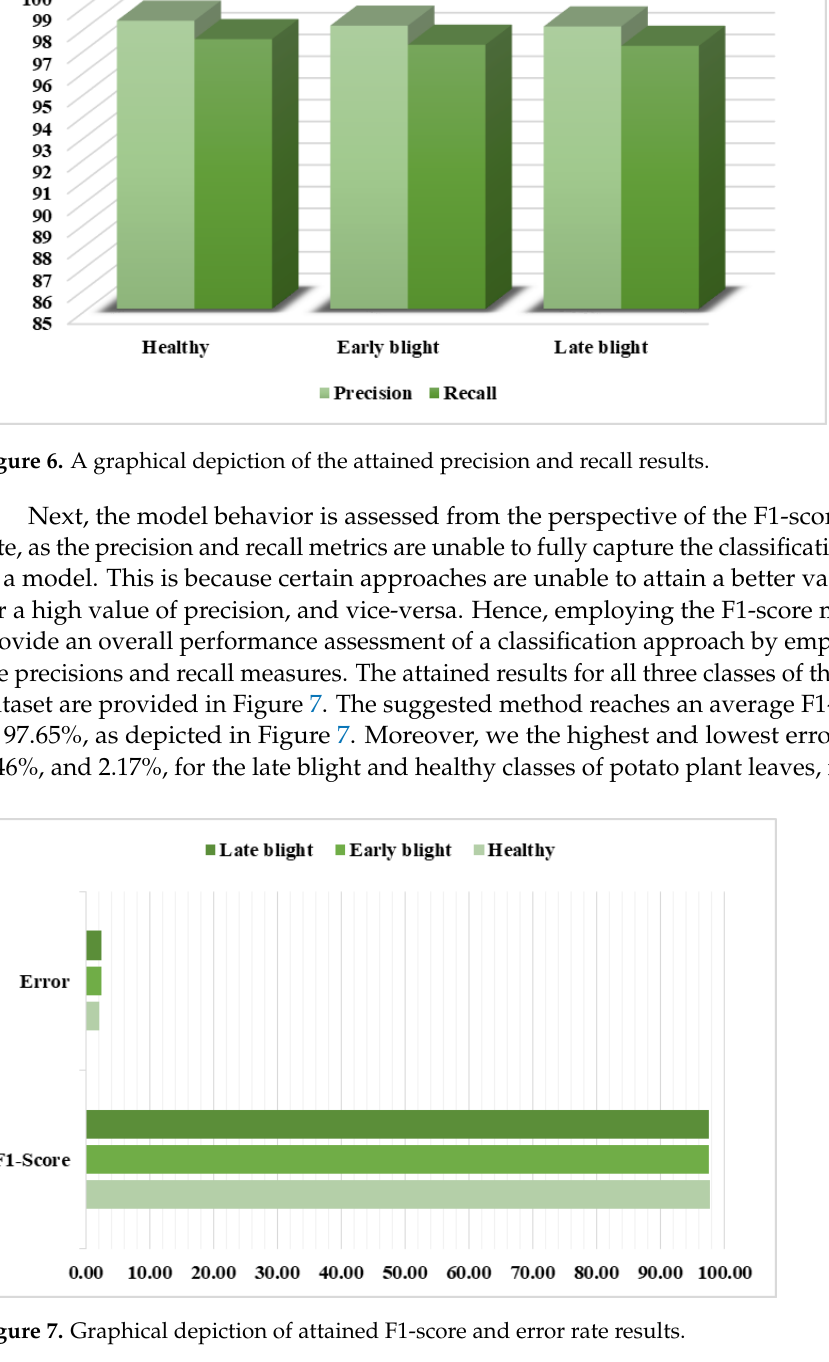
Figure 7. Graphical depiction of attained F1-score and error rate results .